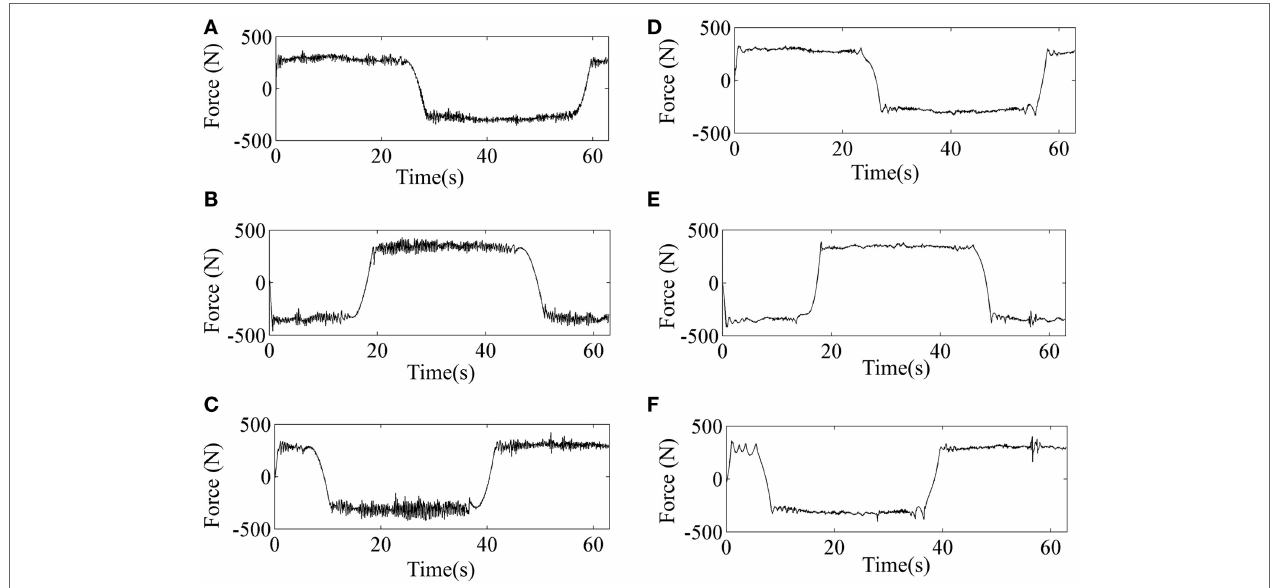
FIGURE 8 | Comparison of the output forces for the three wires by implementation of sliding mode control (SMC) and sliding mode control with nonlinear disturbance observer (SMCNDO) when a healthy subject follows a circle-shaped trajectory. (A) The output force for wire 1 by implementation of SMC, (B) the output force for wire 2 by implementation of SMC, (C) the output force for wire 3 by implementation of SMC, (D) the output force for wire 1 by implementation of SMCNDO, (E) the output force for wire 2 by implementation of SMCNDO, and (F) the output force for wire 3 by implementation of